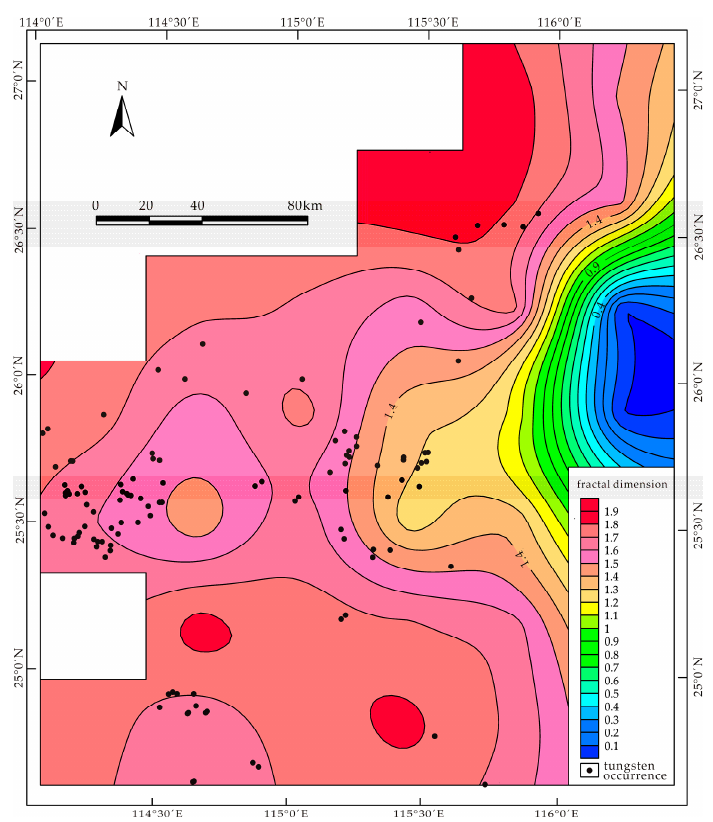
Figure 7. Contour map showing spatial distribution of fractal dimensions of Yanshanian granite.